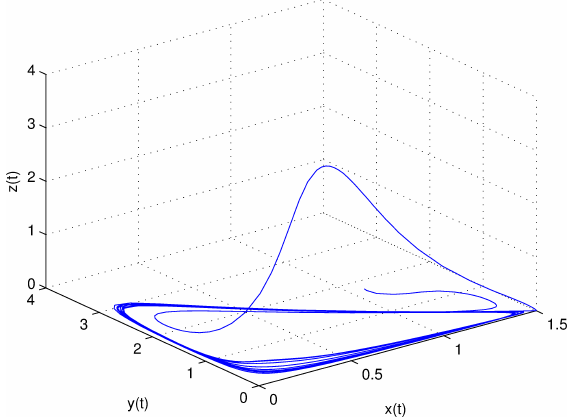
Fig. 8. The phase graph of system .26/ in x (cid:0) y (cid:0) z plane with (cid:28) 1 D 0:9 , (cid:28) 2 D 0:7 and (cid:28) 3 D 0:4 . The initial value is .x.0/ D 0:8;y.0/ D 0:8;z.0/ D 0:7/